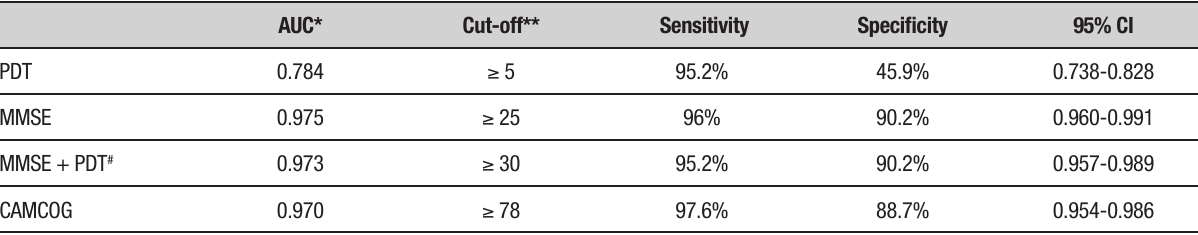
Table 4. Receiver operating characteristic curve areas, cut-offs, sensitivity, and specificity for the PDT, MMSE, MMSE plus the PDT and the CAMCOG between AD and NC groups.